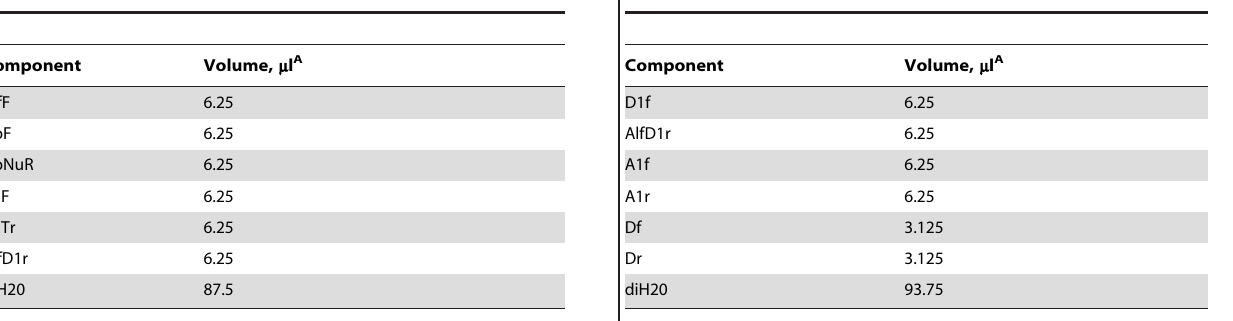
Table 7. Preparation of 125 m l primer stock for V. albo-atrum–